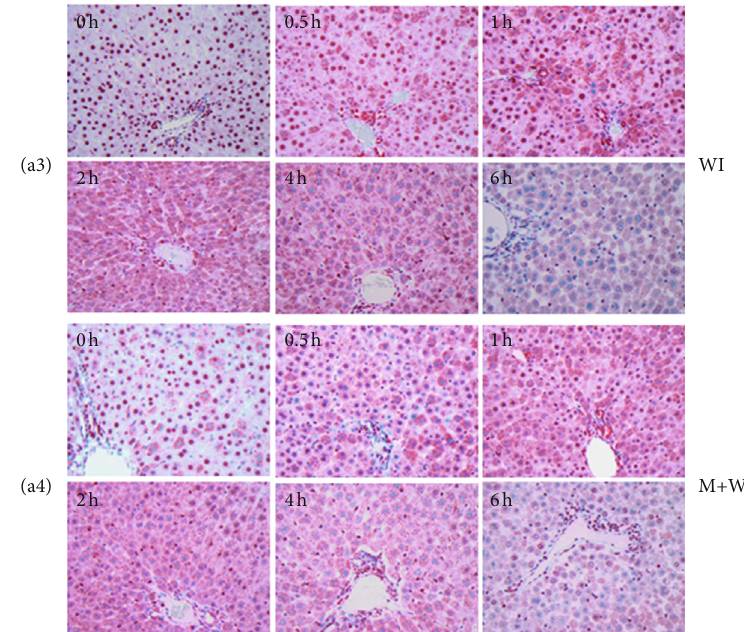
Figure 3: Immunohistochemical analysis of HMGB1 expression in rat livers following cold/warm ischemia. Staining pattern changed upon ischemia and mechanical stress (a). (a3) warm ischemia (WI), (a4) mechanical stress plus warm ischemia